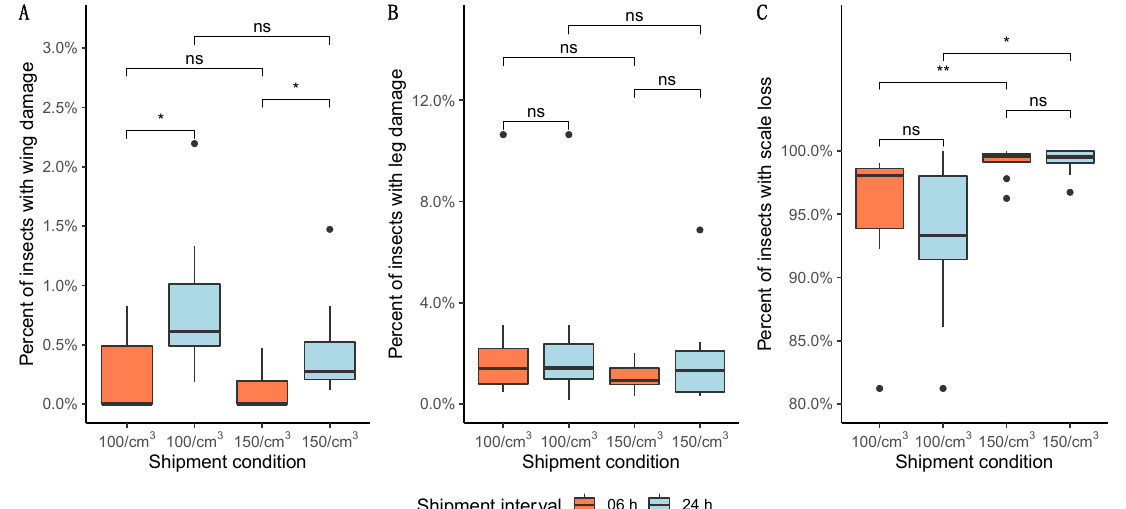
Figure 7. Physical damage after compaction (100 and 150 males/cm3) and shipment interval (06 and 24 h) at 10 °C: ( A ) wing damage; ( B ) leg damage; ( C ) scale loss. Significant differences between treatment groups are indicated by the p -value level. The boxplot shows the median and upper and lower quartiles. Significance values goes as ‘**’ < 0.01, ‘*’ < 0.05, ‘ns’ < 0.1. Black dots correspond to potential outliers among the samples.